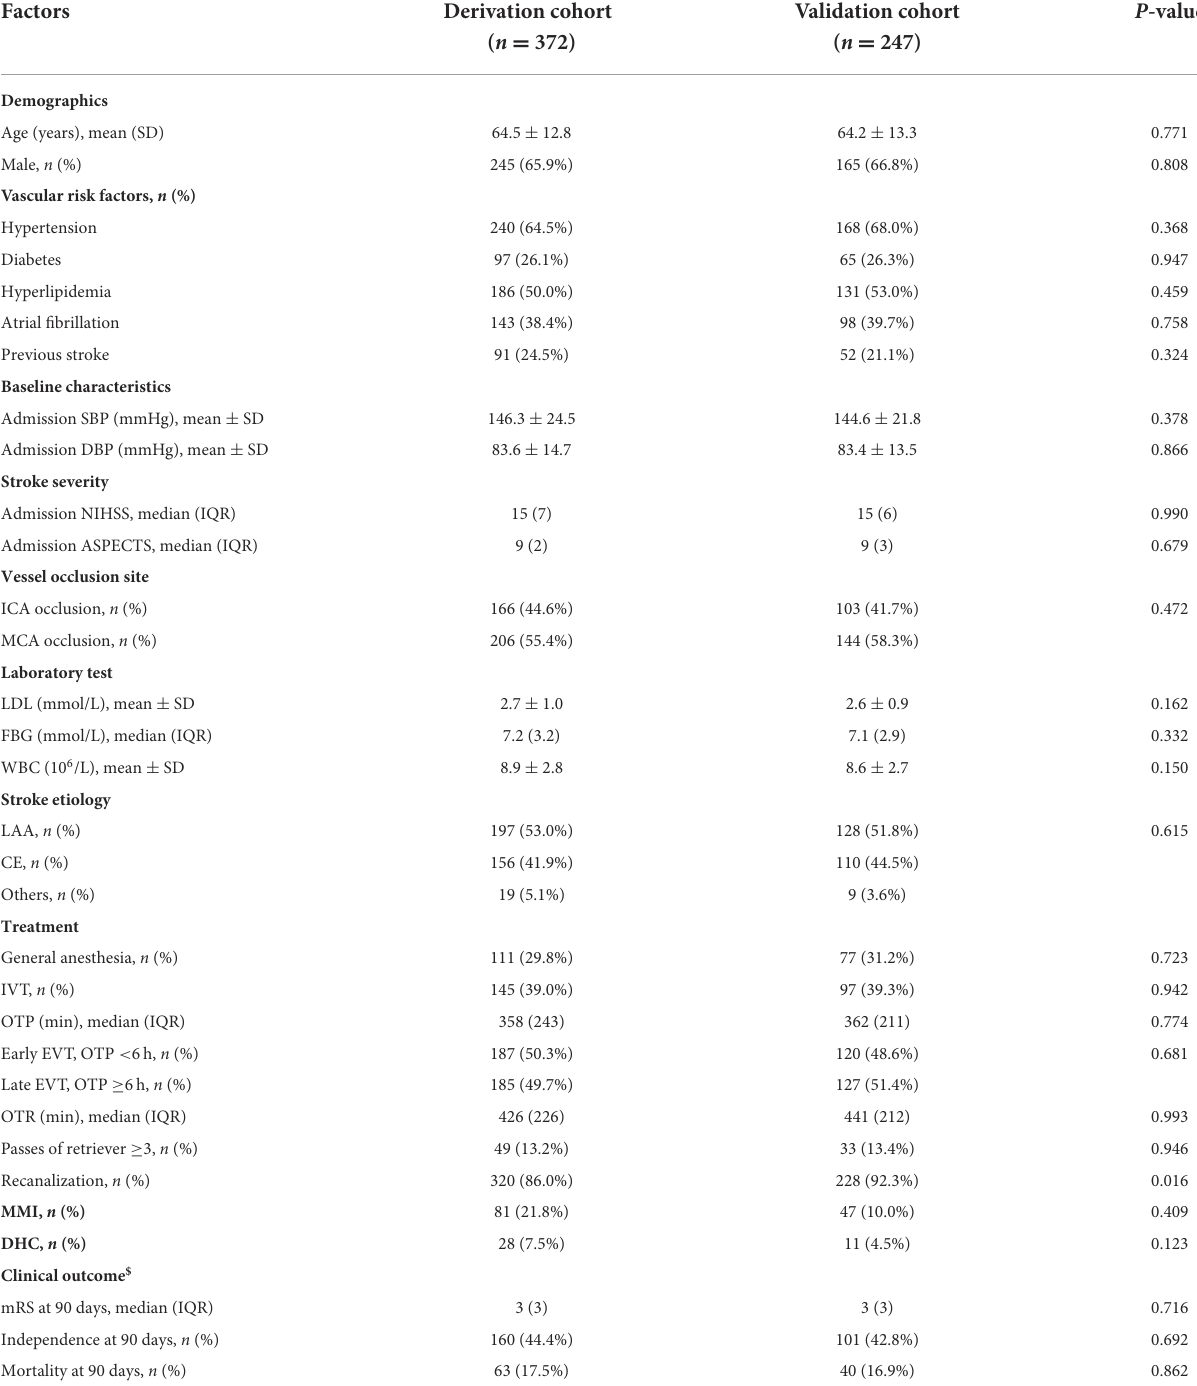
TABLE 1 Characteristics of patients in the derivation and validation